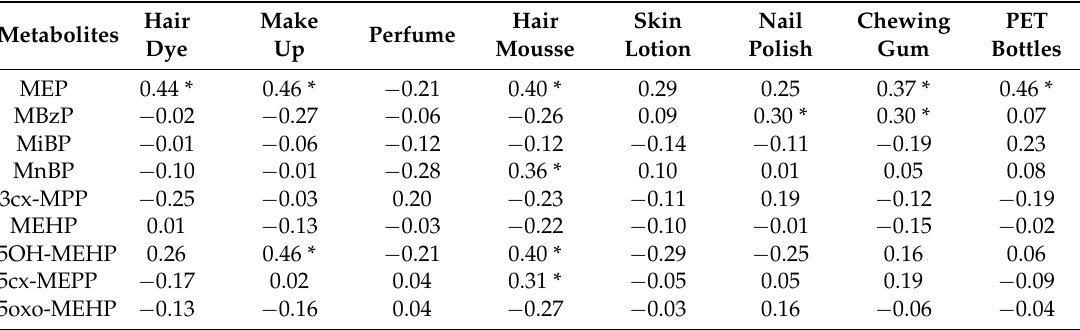
Table 3. Spearman correlation coefficients (* p < 0.05) of phthalate metabolites and intensity of use of some consumer products in